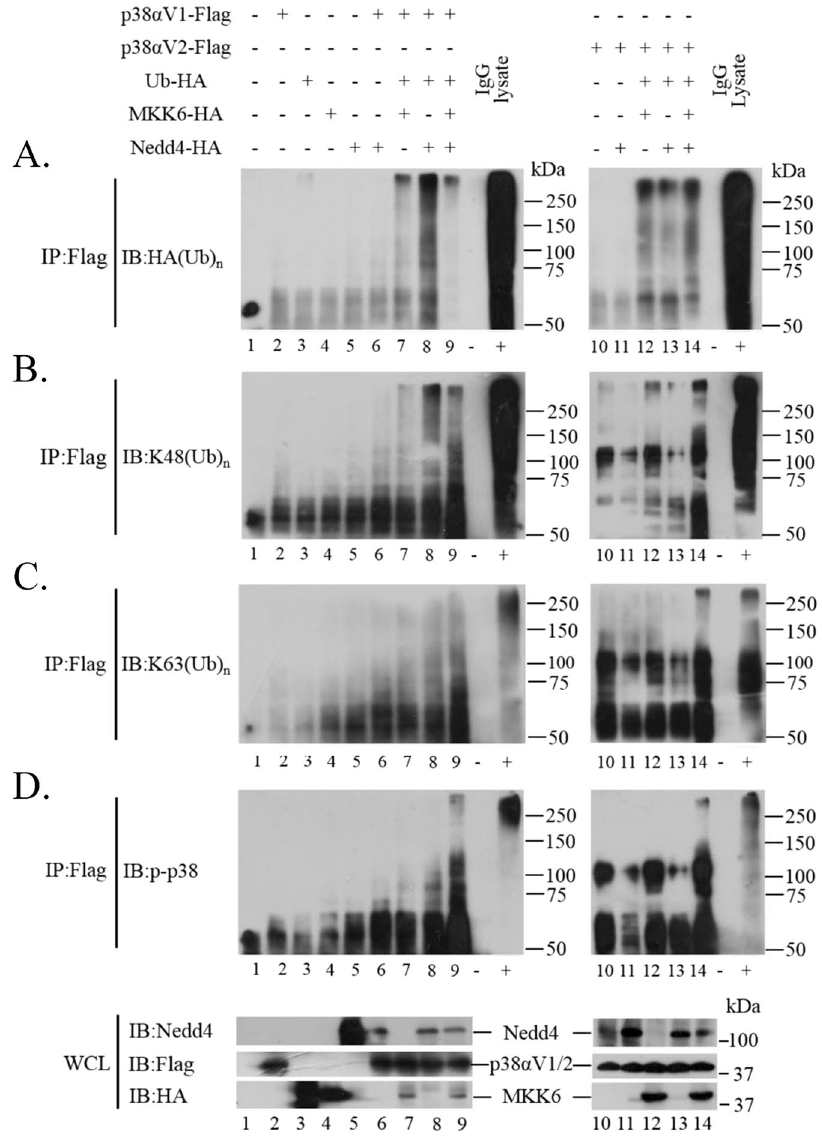
Figure 5. Nedd4 mediates polyubiquitination of p38 α isoforms (Left. Ubiquitination of p38 α V1; Right. Ubiquitination of p38 α V2). Immunoblot analysis of anti-Flag immunoprecipitates of lysates of 293T cells co- transfected with various molecules (above lanes), probed with anti-HA ( A ), anti-K48 ubiquitin ( B ), anti-K63 ubiquitin ( C ) and anti-p-p38. For whole cell lysates, p38 α V1 and p38 α V2 were probed with anti-Flag, MKK6 was probed with anti-HA and Nedd4 was probed with anti-Nedd4. Lane 3 just showed the signals of ubiquitinated proteins, not